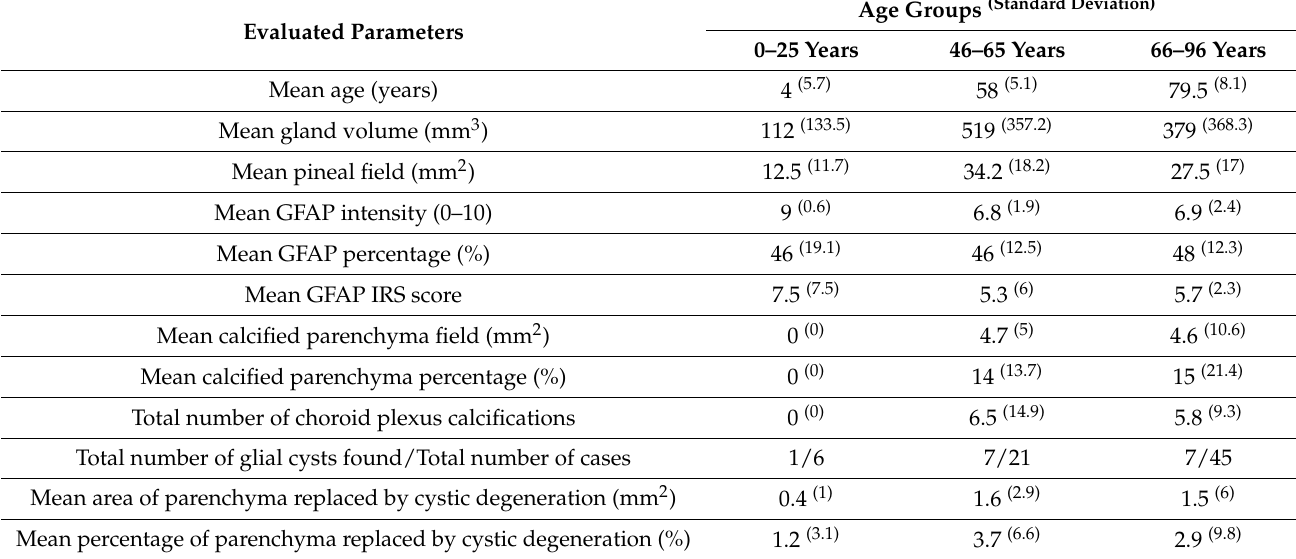
Table 1. Evaluated parameter results and standard deviation in relation to age groups Evaluated